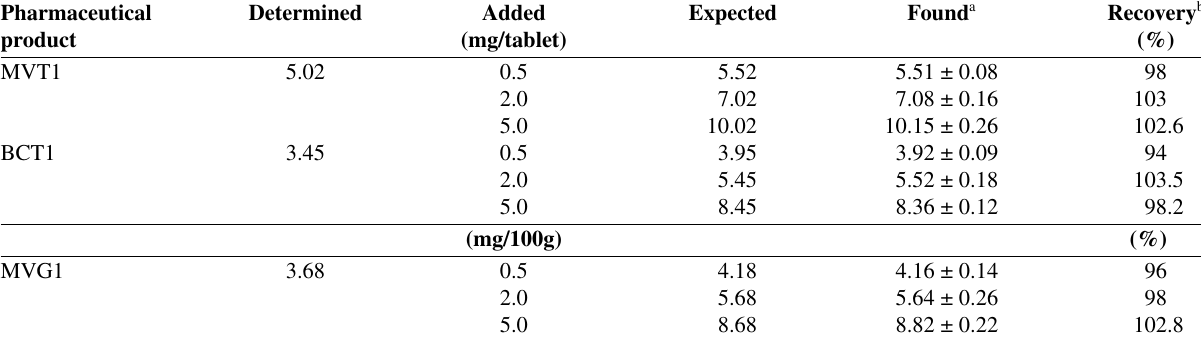
Table 4 . Recovery analysis of riboflavin in pharmaceuticals using proposed chronopotentiometric method ( n = 5)